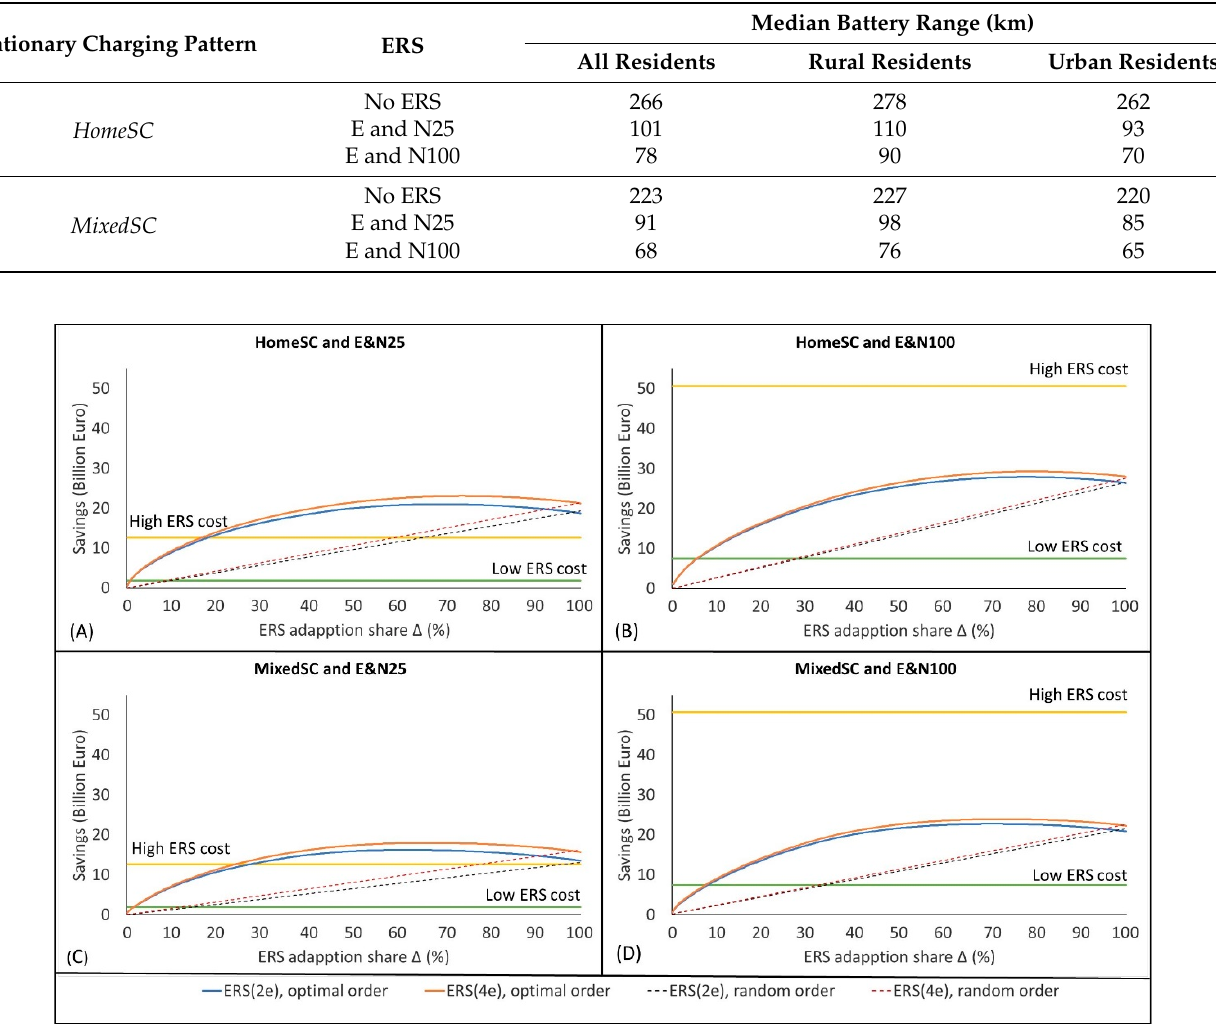
Figure 6. Savings in billion euros during the ERS lifetime from reduction in required battery capacity as a function of ERS adoption share ∆ in vehicle fleet with ( A ) HomeSC and E and N25, ( B ) HomeSC and E and N100, ( C ) MixedSC and E and N25, and ( D ) MixedSC and E and N100, with 2 e and 4 e ERS charging power rates. The savings are calculated based on Equation (2) (optimal order) and (3) (random order), respectively. HomeSC and MixedSC refer to home-only stationary charging and home and other stationary charging, respectively.